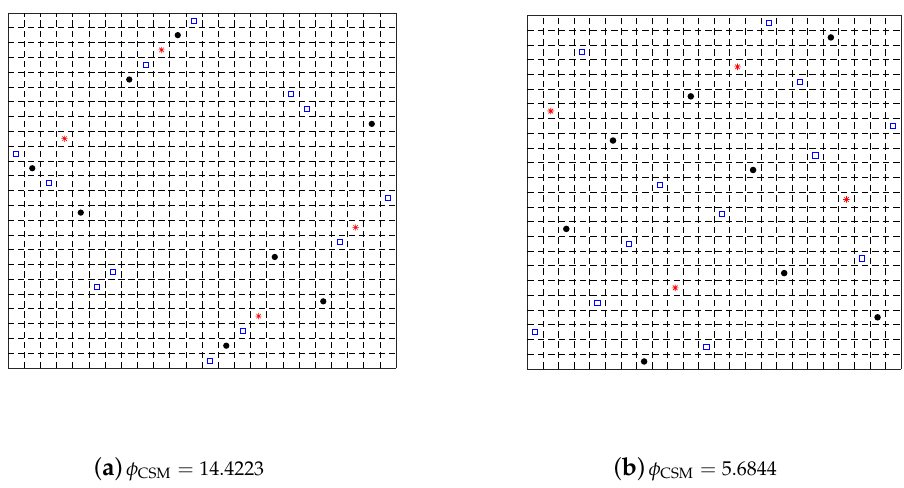
Figure 5. Optimization results for finding optimal FSLHD. ( a ) the initial FSLHD ( 4,8,12;3,2 ) in Example 1, different types of points denote difference three slices, respectively; ( b ) the optimization results of FSLHD ( 4,8,12;3,2 ) after using the SESE